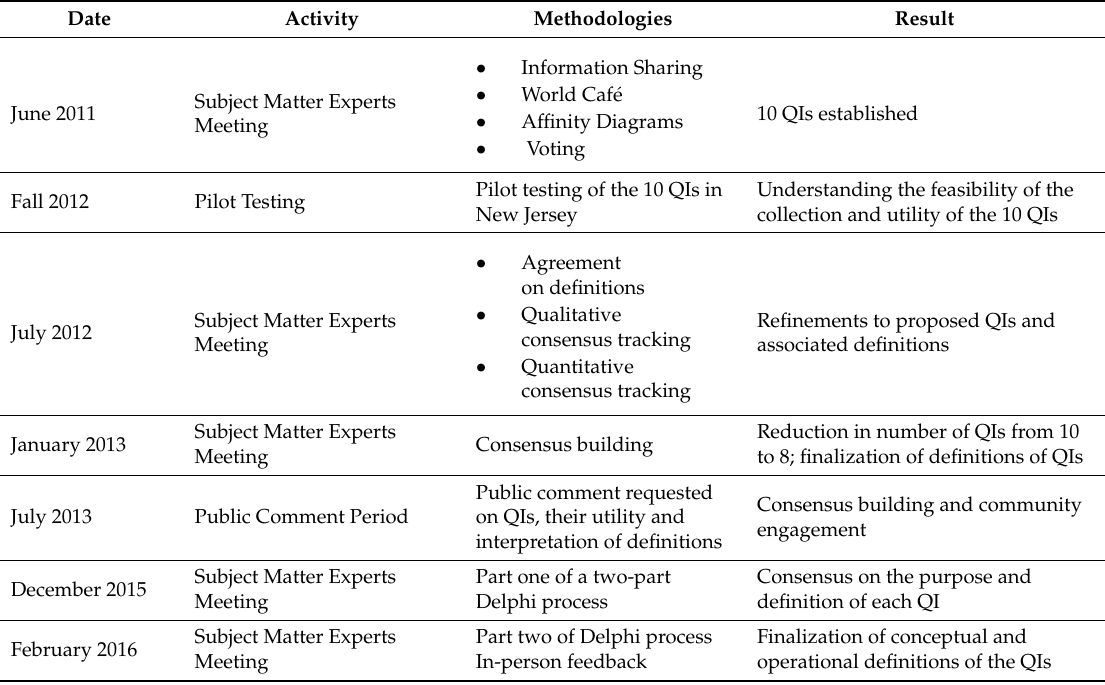
Table 1. Summary of Iterative Methods to Establish Newborn Screening Quality